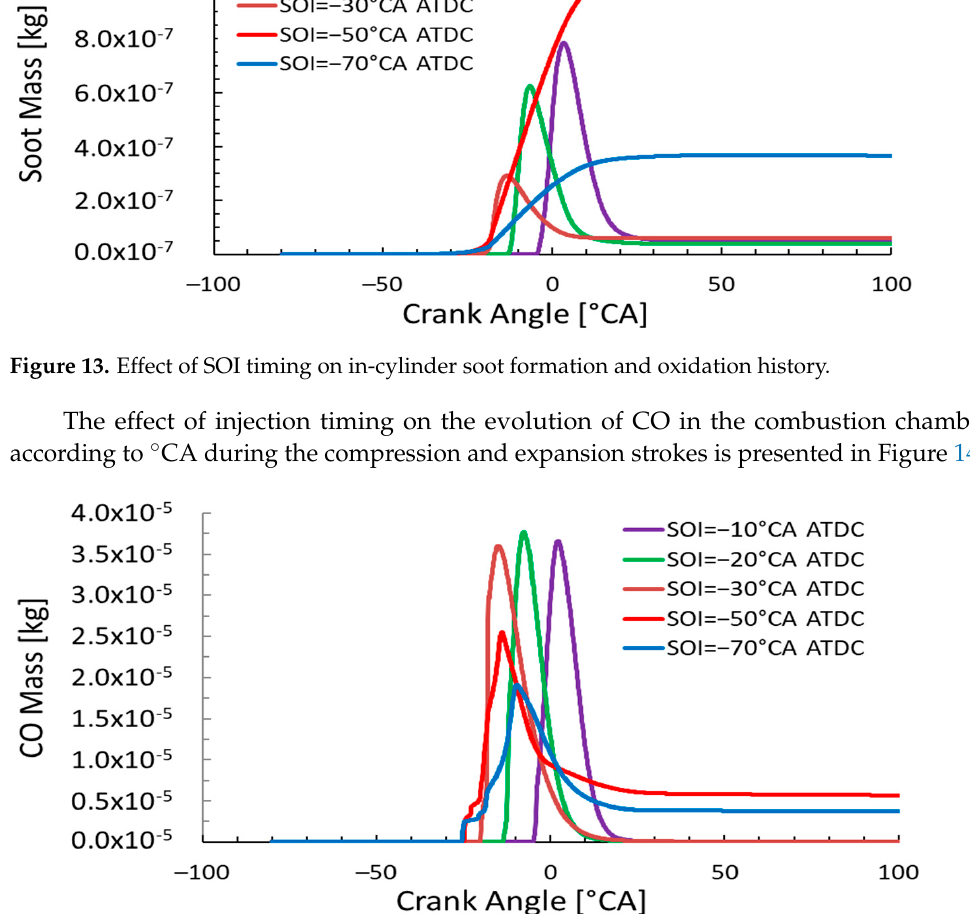
Figure 14. Effect of SOI timing on the in-cylinder CO formation and oxidation history.